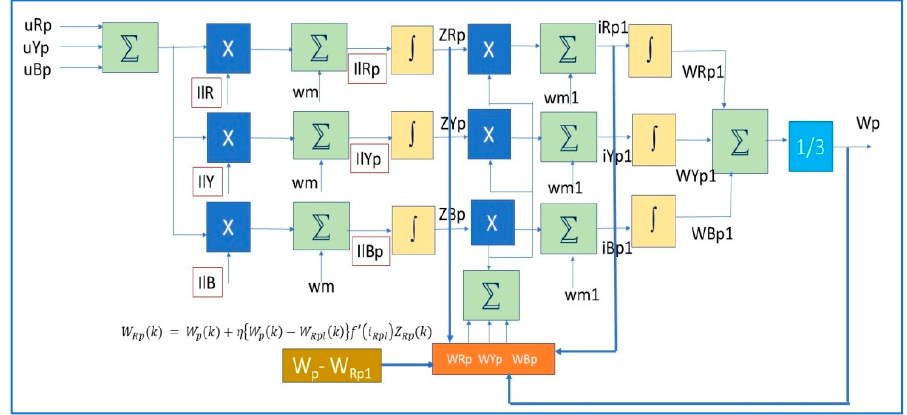
Figure 7. Configuration of backpropagation-based ANN model.